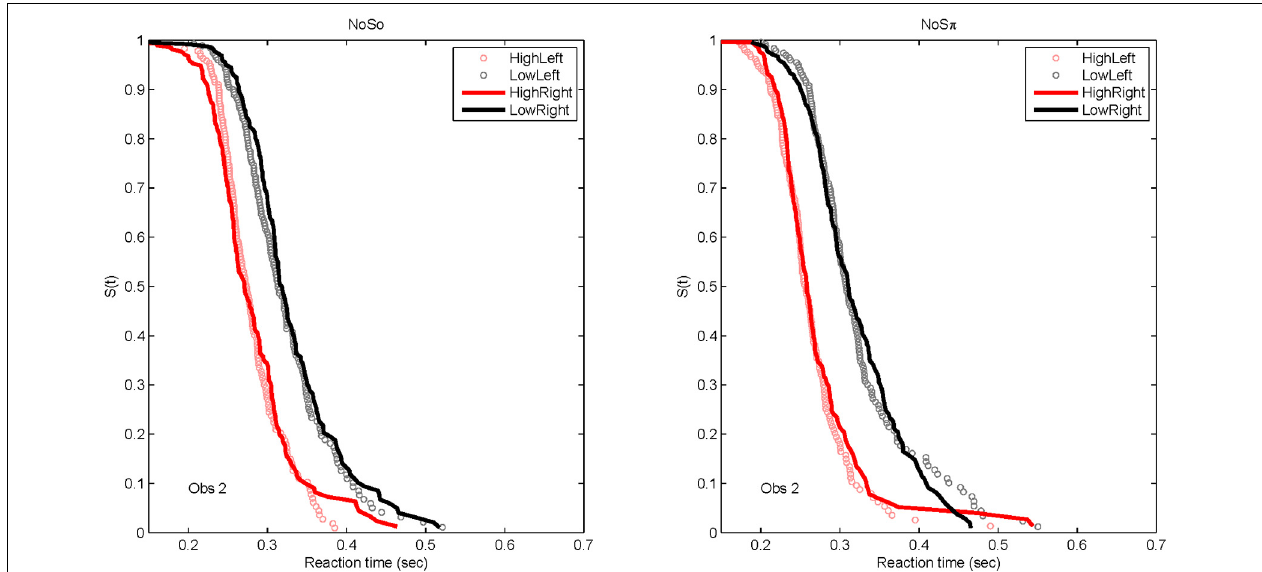
FIGURE 6 | Derived survivor functions for the single-target conditions at the two SNRs for the left and right ears in the two contexts: N 0 S 0 (left panels) and N 0 S π (right panels) for a single representative